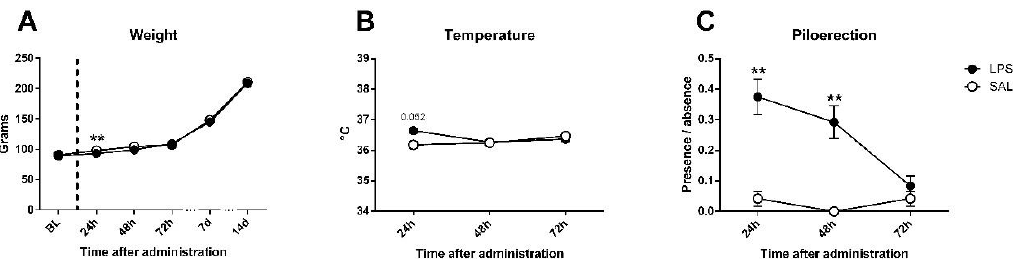
Figure 2. Sickness assessment with the aid of functional observational battery (FOB) in saline (SAL) and Lipopolysaccharide (LPS) treated animals. ( A ) Bodyweight evolution of experimental subjects: no differences existed in baseline, but LPS induced a deficit in weight gain in treated animals 24 h after administration; differences disappeared at 48 h and groups remained equal until the last assessment (14 days later). ( B ) Temperature data: a trend towards significance was present 24 h after administration, where LPS-treated group exhibited higher temperature, but not 48 or 72 h later. ( C ) Piloerection presence/absence (index from 0 to 1): a strong effect was found on LPS-treated animals 24 and 48 h after immune challenge, and disappeared 72 h later. Asterisk represents LPS effect. Data is represented as mean ± standard error of the mean